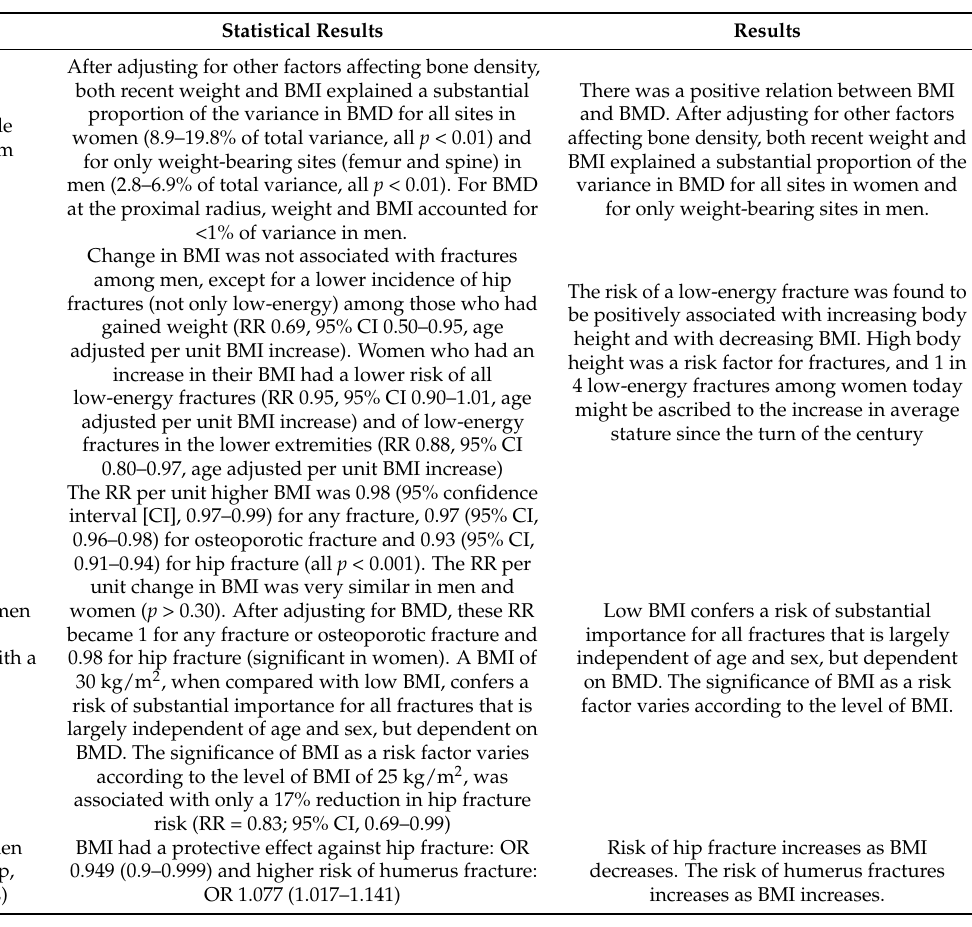
Table 1. Main studies focused on the relation between obesity and bone mineral density/fracture